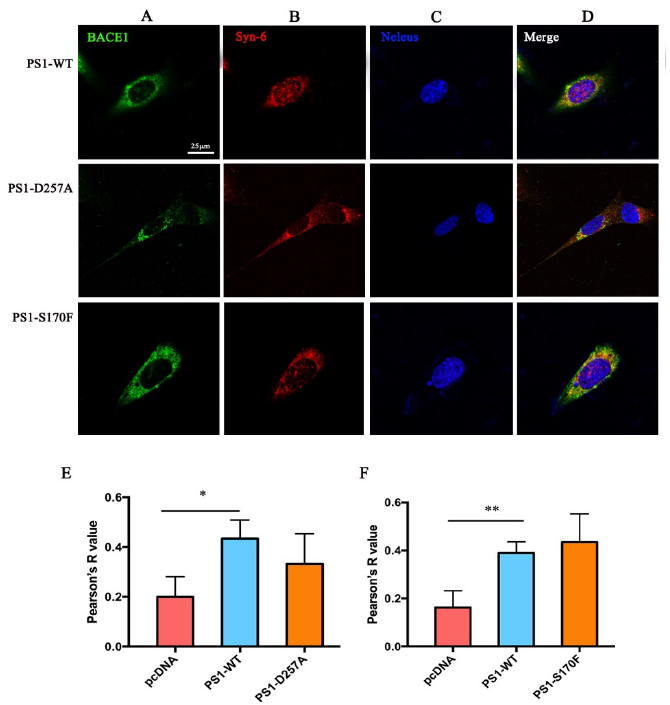
Figure 8. Effect of PSEN1 mutations on colocation of BACE1 and the Golgi (scale bar = 25 μm). ( A ) BACE1. ( B ) Syn-6. ( C ) Nucleus (Hoechst33258). ( D ) Merged picture. Quantification of the colocalization ratio of BACE1 and the Golgi under the PSEN1 mutations D257A ( E ) and S170F ( F ). One-way ANOVA: ** p < 0.01, * p < 0.05 ( n = 3).